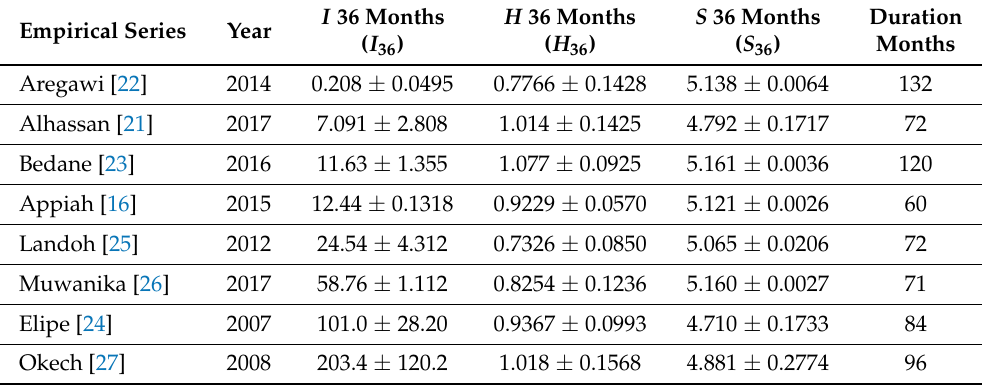
Table 1. The empirical values of average malaria incidence I (malaria cases per 100 inhabitants, per year), the Hurst exponent H and Shannon entropy S , concerning a 36-month time frame. Errord indicate standard deviations from the series by using moving windows of 36